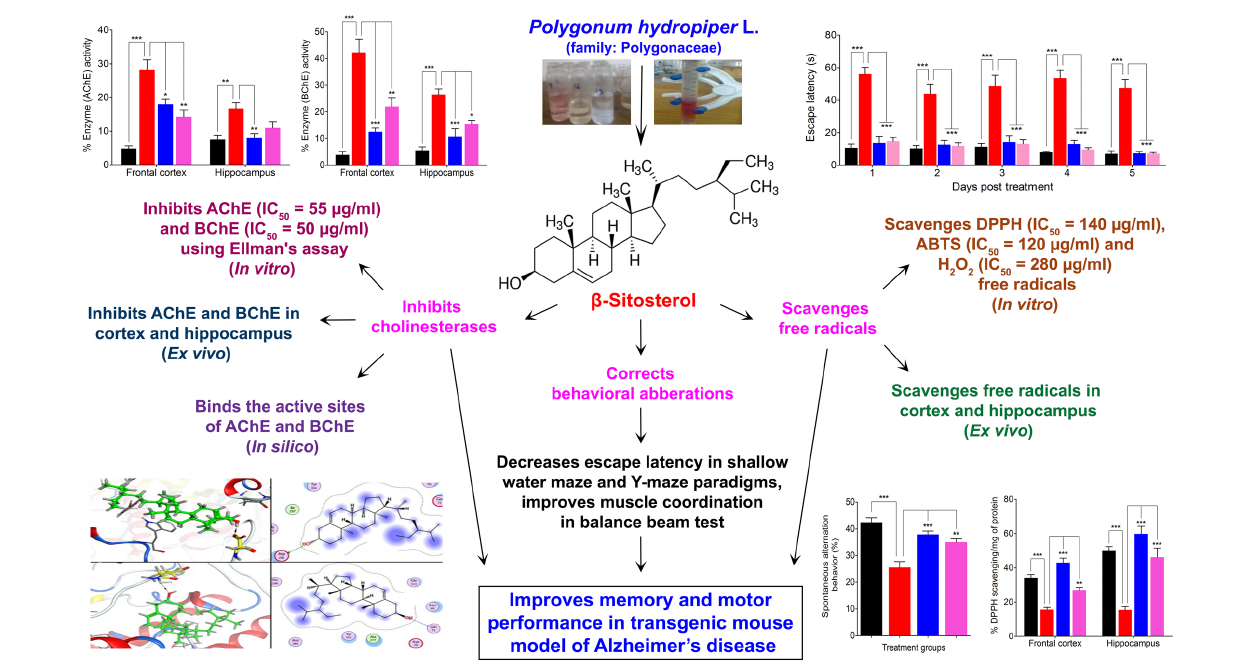
FIGURE 9 | Scheme summarizing the anti-Alzheimer property of β -sitosterol isolated from Polygonum hydropiper